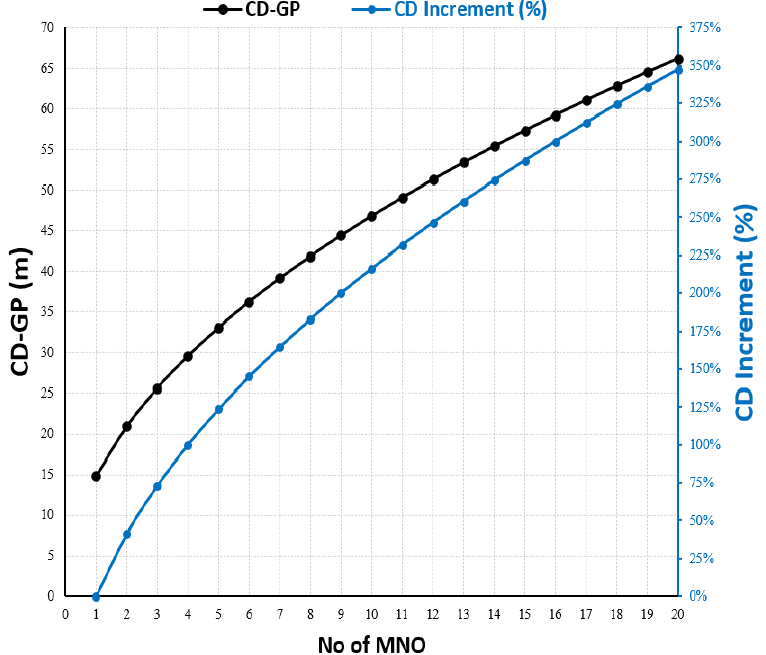
Figure 9. The compliance Distance for GP at macro site shared by N number of MNOs using the typical RF configuration in Table 4.